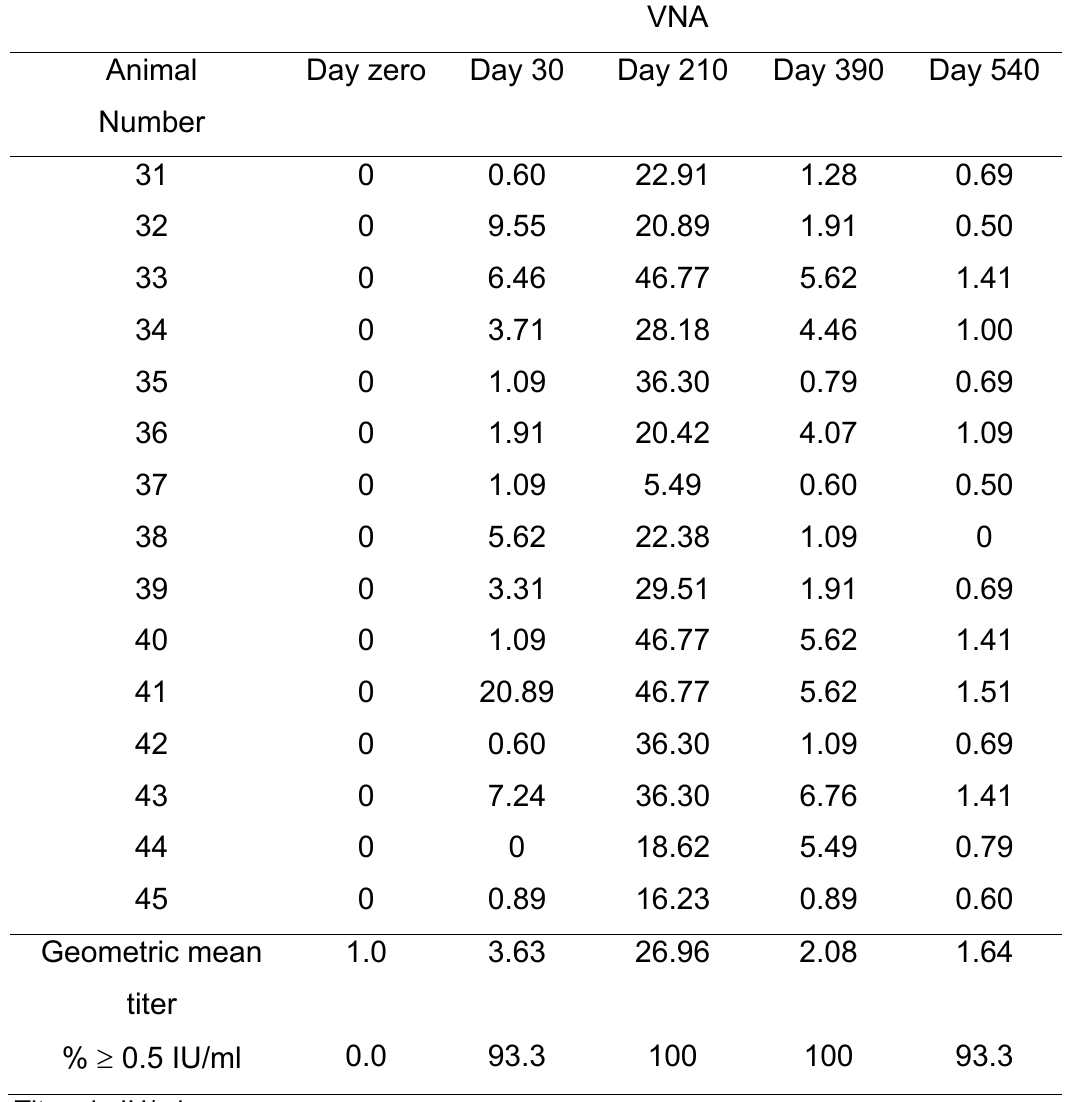
Table 3: Virus neutralizing antibody (VNA) titers in cattle that received a booster 180 days after the primary immunization (Groups